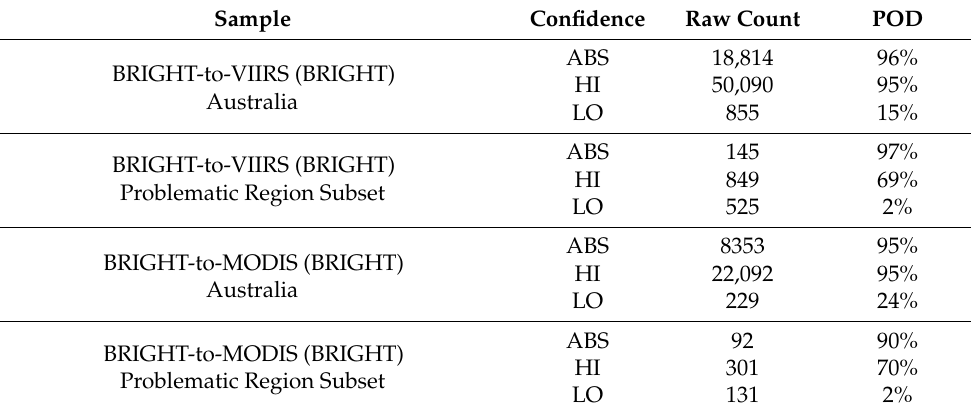
Table 2. Day-time BRIGHT-to-VIIRS (BRIGHT) and BRIGHT-to-MODIS (BRIGHT) raw counts and PODs separated by sample and confidence; separately for Australia and for the problematic subset (Victorian Volcanic Plain (SVP01), Victorian Alps (AUA02), Barrington (NNC13), and Brisbane- Barambah Volcanics (SEQ05)). For the definition of ABS, HI, and LO, see Section